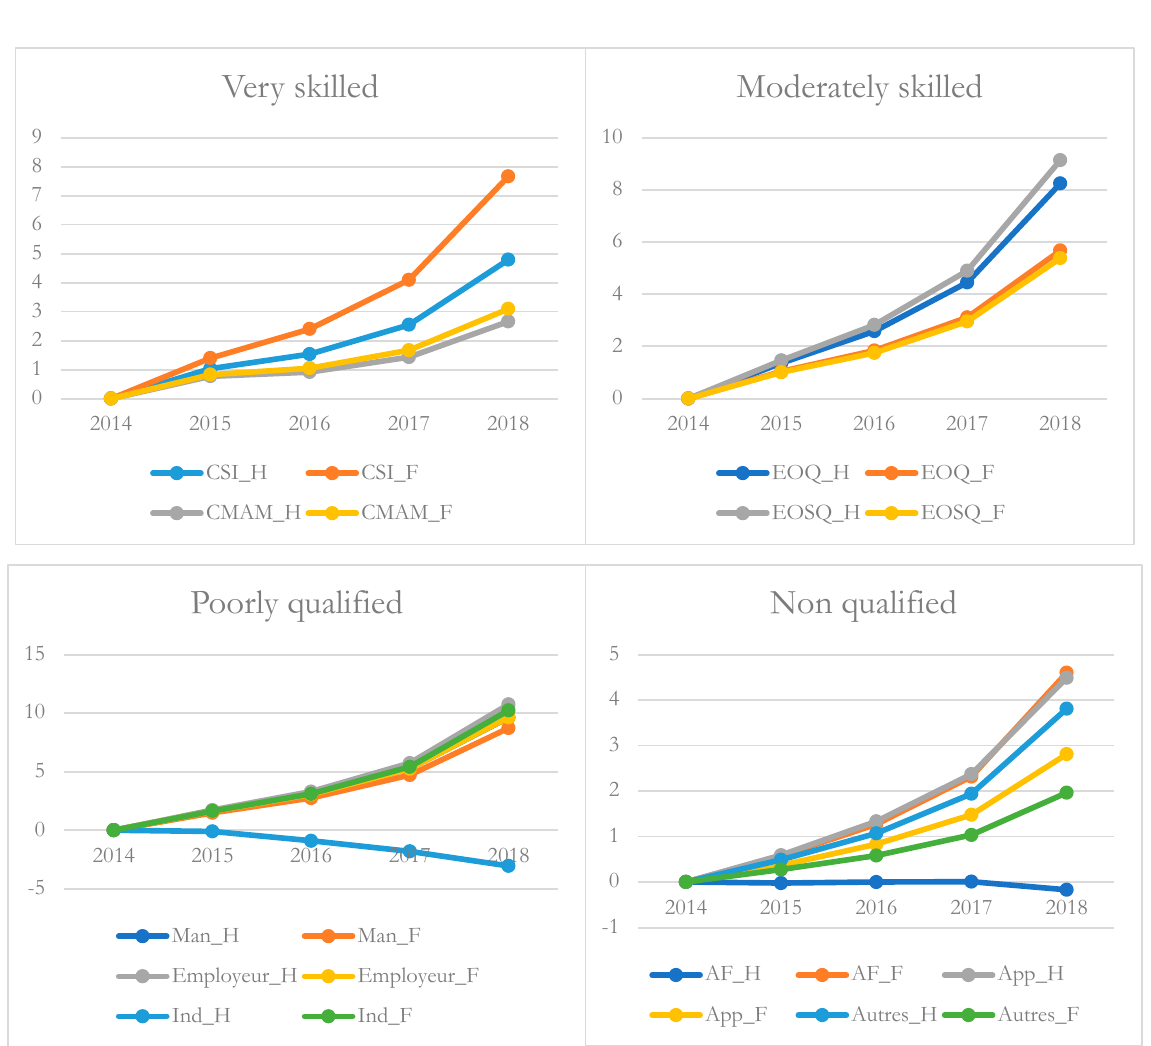
Figure 6. Evolution of labor demand from segments of the labor market (in% compared to the BAU scenario). Source: Authors, based on simulations. Note: CSI = senior executive and engineer; CMAM = middle manager and supervisor; EOQ = employee and skilled worker; EOSQ = employee and semi ‐ skilled worker; Man = maneuver; Ind = independent; AF = family helpers; App = apprentice.